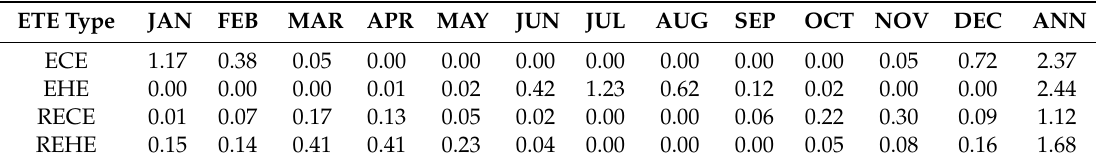
Table 2. Mean number of ETE days / year by month, averaged across all 51 metropolitan areas for the period of